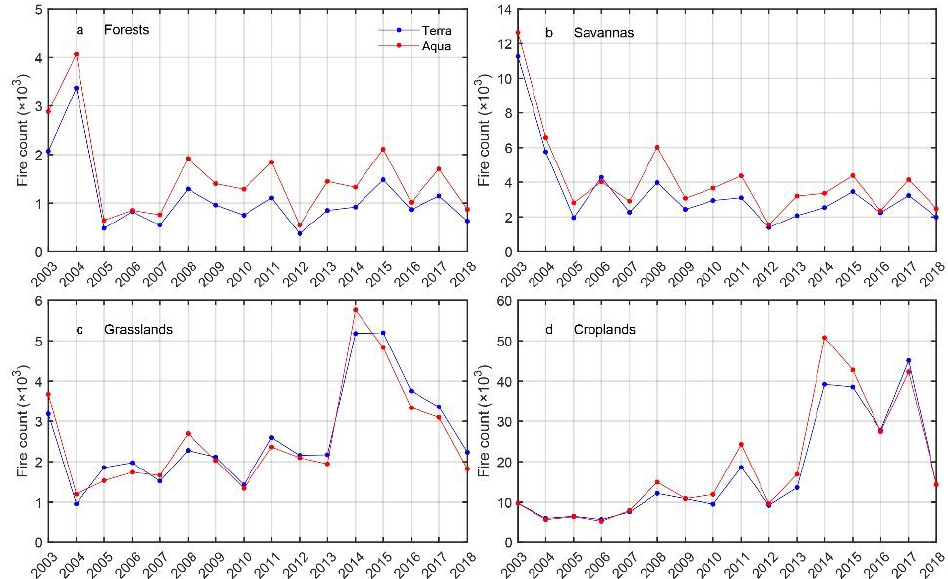
Figure 8. Annual fire counts in different land cover types during 2003–2018 from Terra and Aqua fire products. Error bars indicate one fifth of the standard deviation.